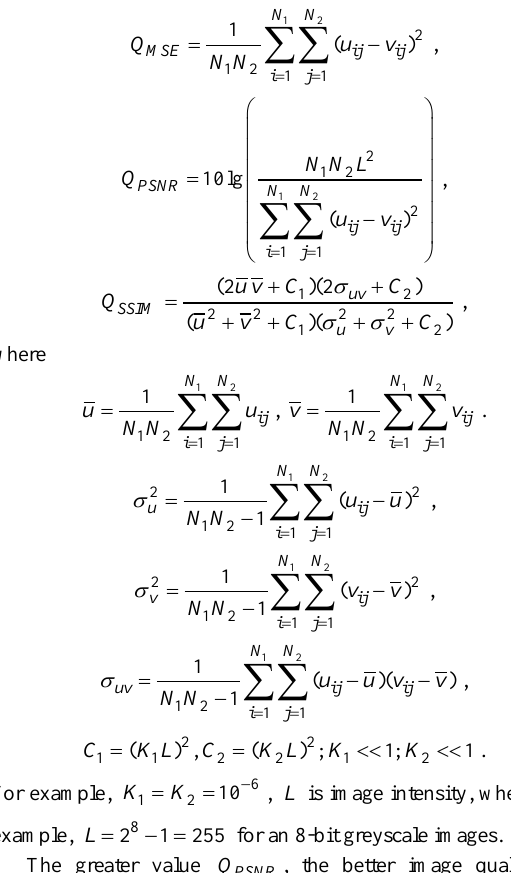
(Figure 1c) and second, create noisy image by adding Poisson noise (Figure